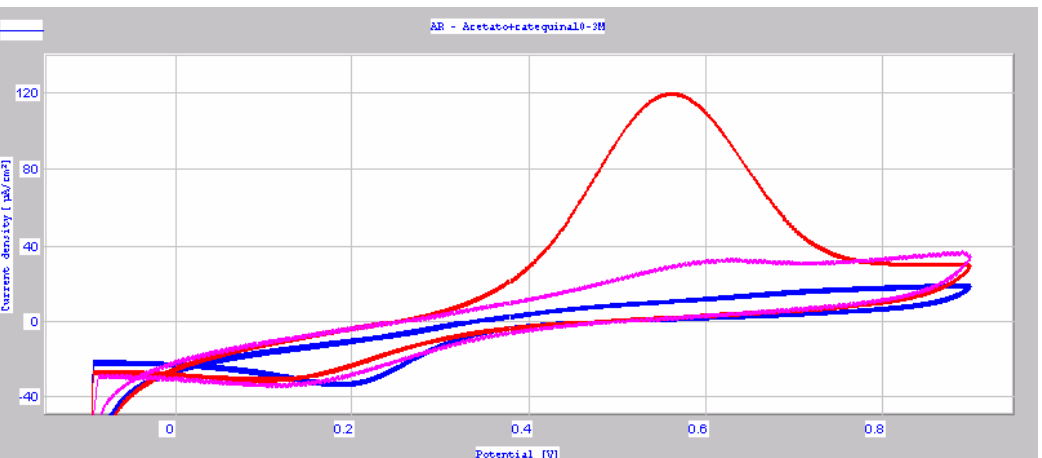
Figure 3. Stability of the biosensor.